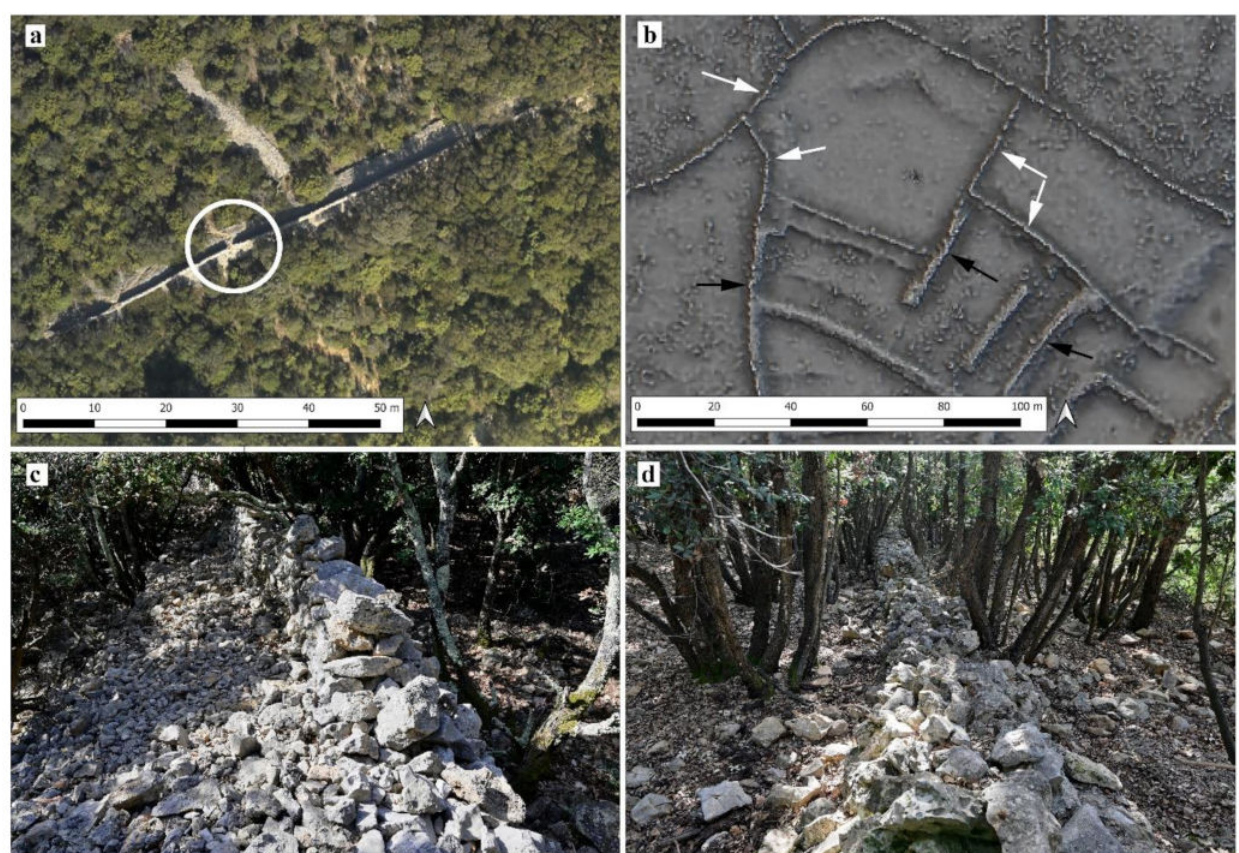
Figure 12. ( a ) Orthophotograph produced simultaneously with the ALS data acquisition in March 2012. As on-site stratigraphical observations show, the recent dry stone wall is built on top of a stone deposit 6 m across. Both are interrupted by a recent path (white circle). ( b ) Positive Openness and Multiple hillshade showing the clear signature of modern dry stone walls (DFM filtered with “stone_wall” setting). Black arrows point at single, white arrows point at double walls. ( c ) Single wall on top of massive stone deposit. ( d ) Double wall (Photo: M. Doneus, 13 April 2022). The walls form a system extending across an area of 350 × 150 m, enclosed by